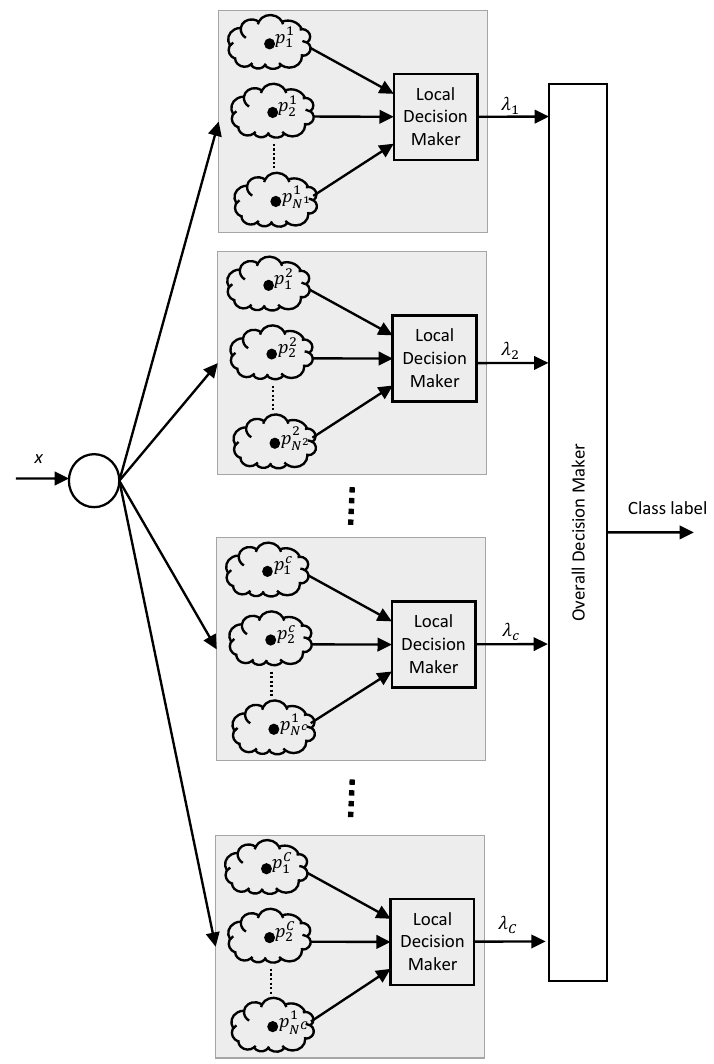
Figure 8. Architecture of Self-Organizing Fuzzy Logic (SOF)